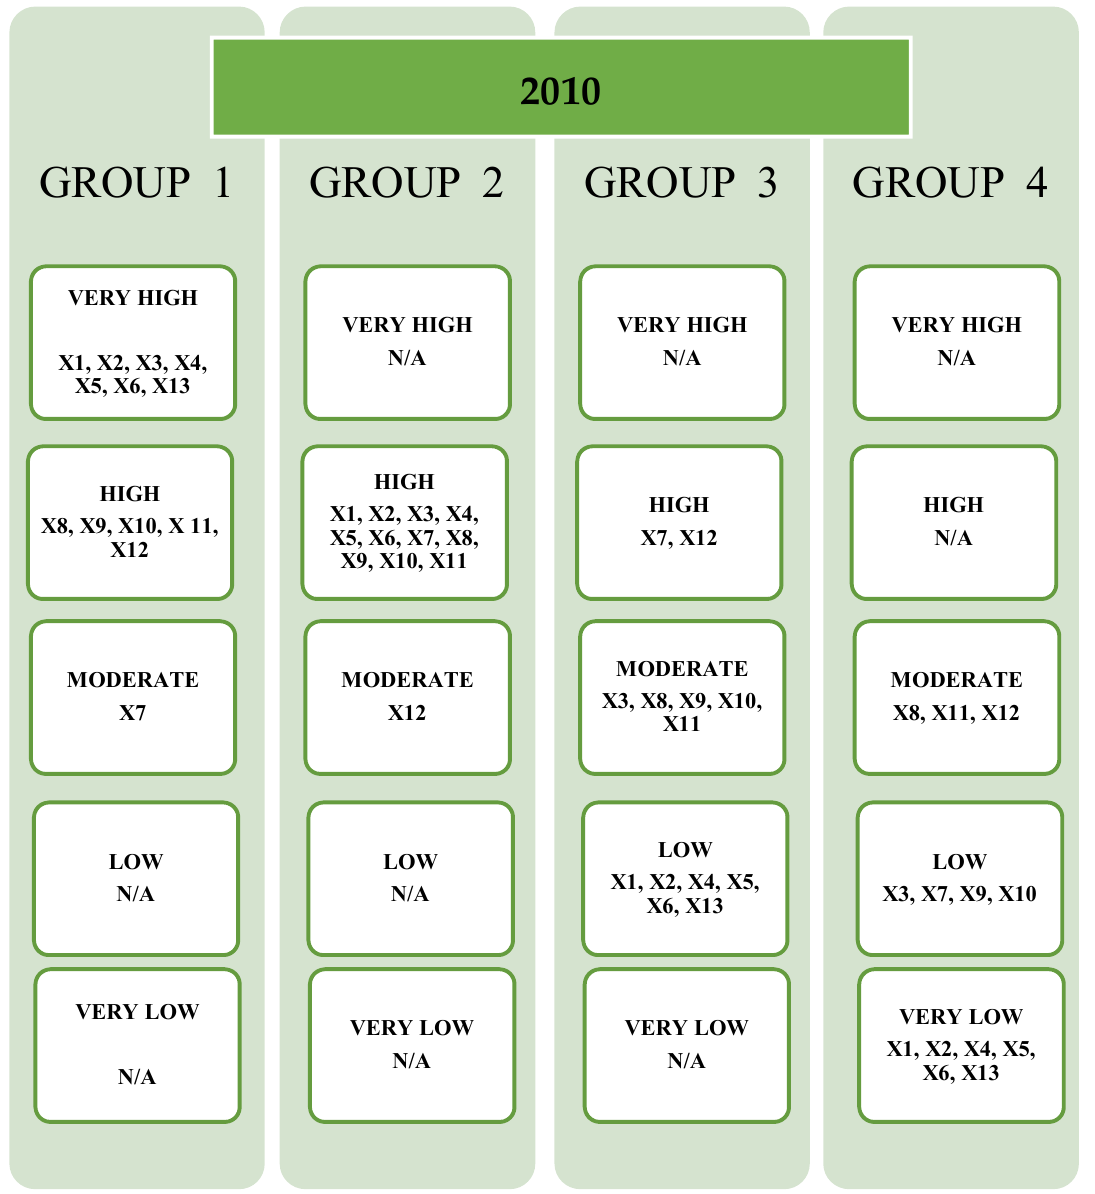
Figure 4. Characteristics of individual groups based on the relation of group mean values to the total means for individual variables in 2010 and 2019. Source: Authors’ own compilation based on Eurostat data.